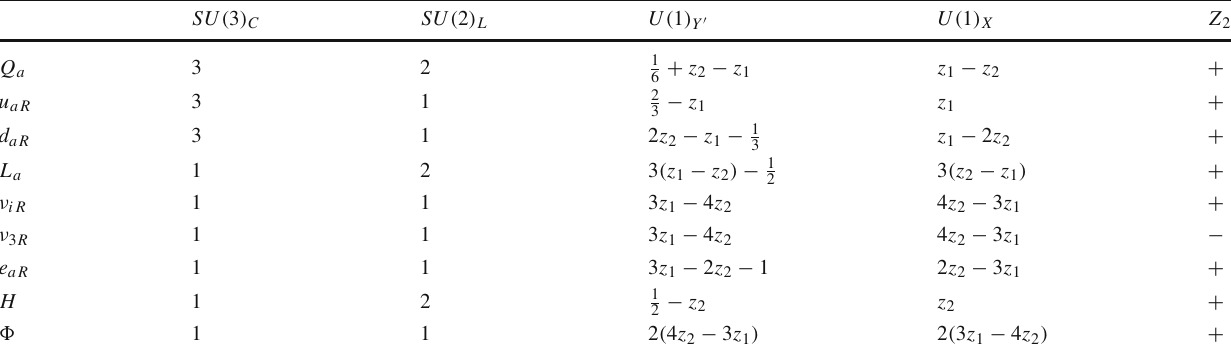
Table 1 The charge assignement for the fermions and scalars under the symmetry GSM × Z 2 where z 1 and z 2 are the free parameters with a = 1 , 2 , 3 and i = 1 ,